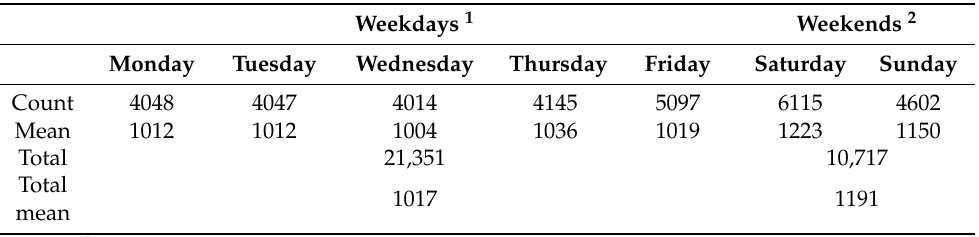
Table 1. Overview of electric vehicle (EV) groups derived from location-based service (LBS) data (collection and description).